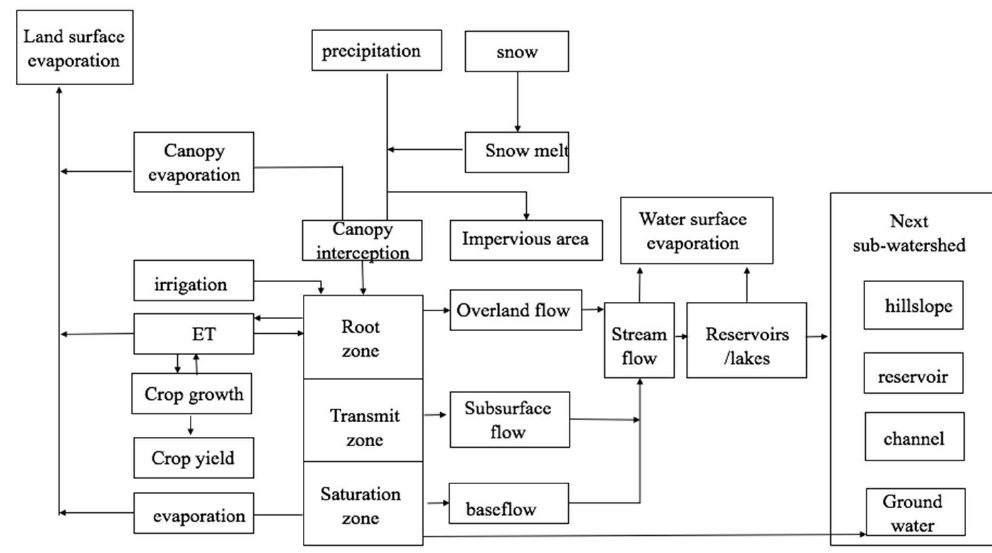
Figure 2. Structure of the HIMS model. Table 1. Main equations of the customization HIMS model.